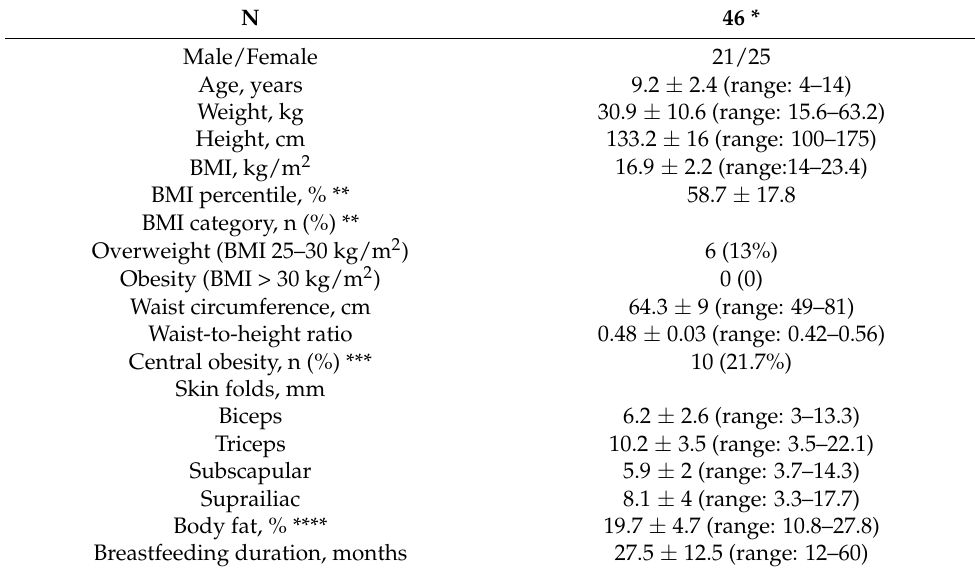
Table 1. Demographic and somatometric characteristics.